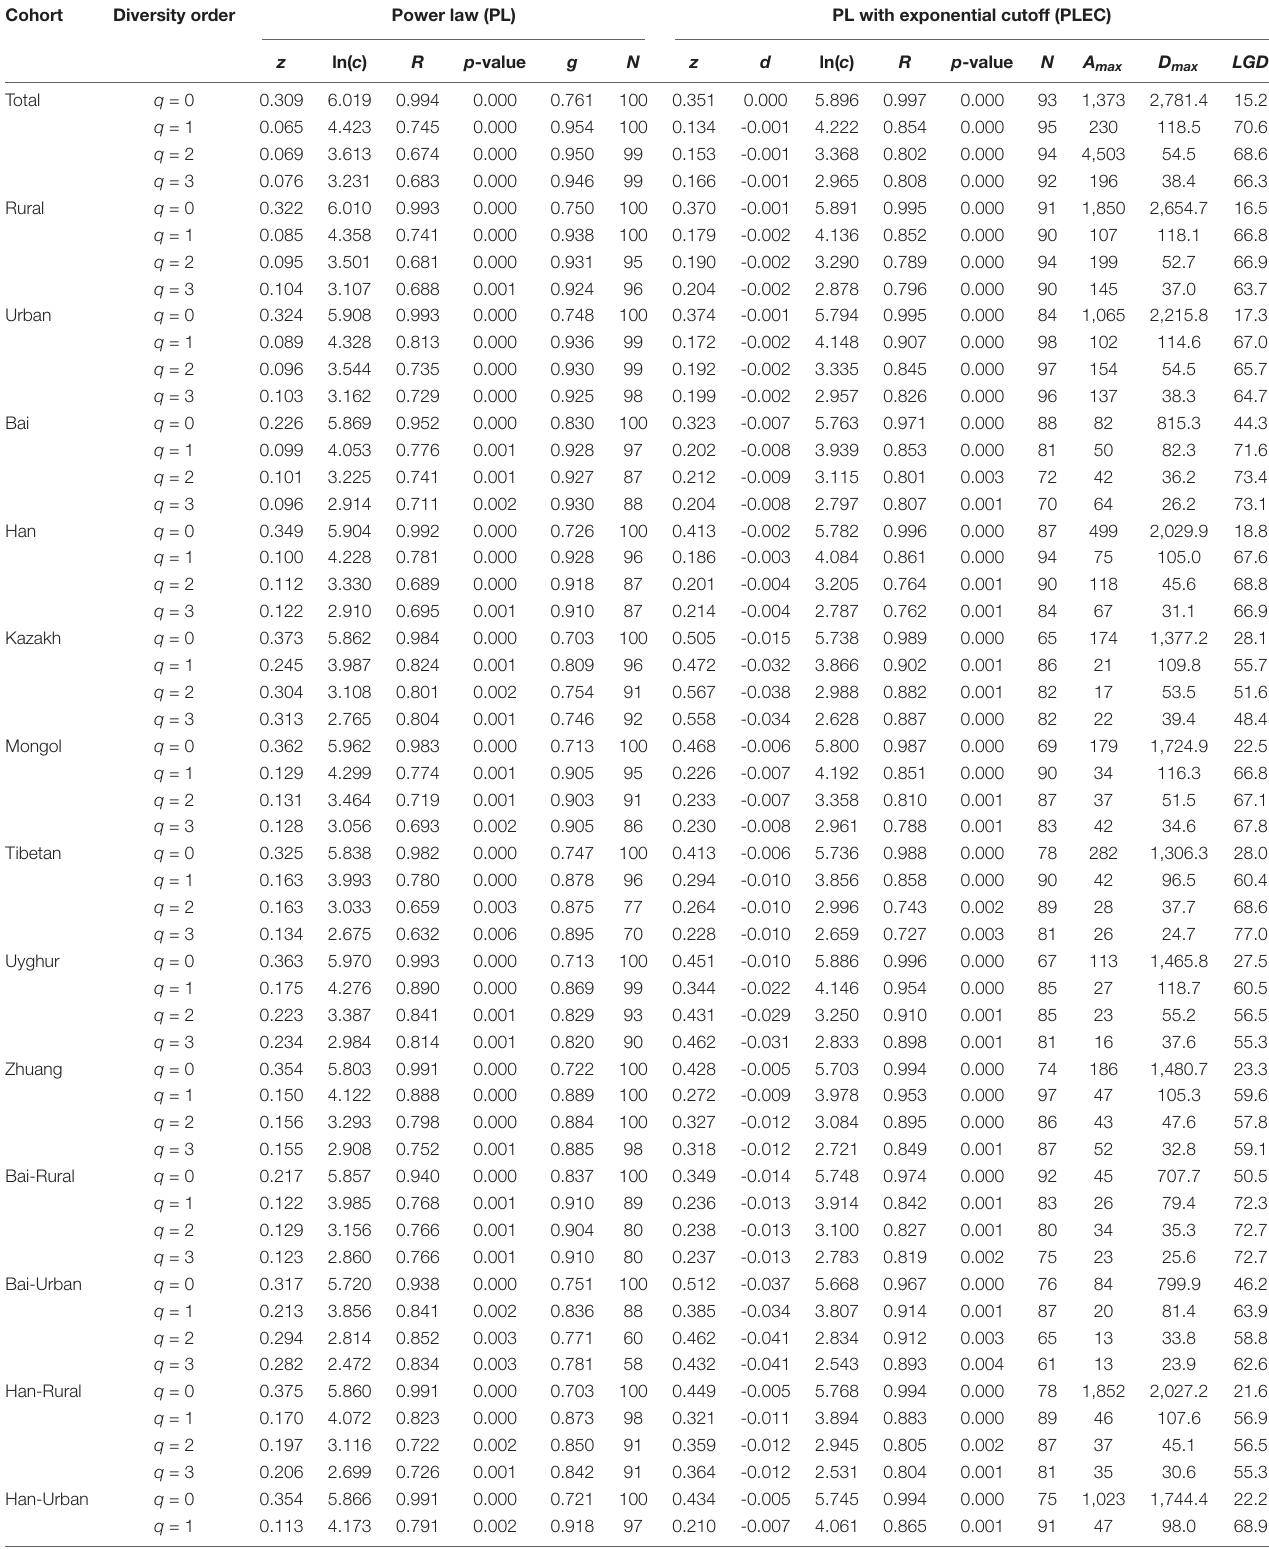
TABLE 1 | Fitting the DAR models for all cohorts of the Chinese gut microbiome datasets (with 100 times of random permutations of microbiome samples) (see Supplementary Table 1 for the phylum-, family-, and genus-level counterpart results; only species-level results are shown here). Cohort Diversity order Power law (PL) PL with exponential cutoff (PLEC)